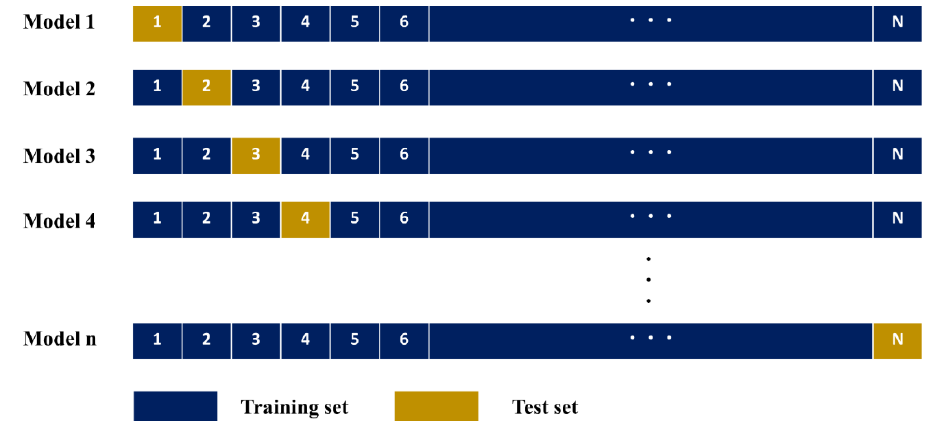
Figure 3. Schematic representation of the leave-one-out cross-validation (LOOCV) method.